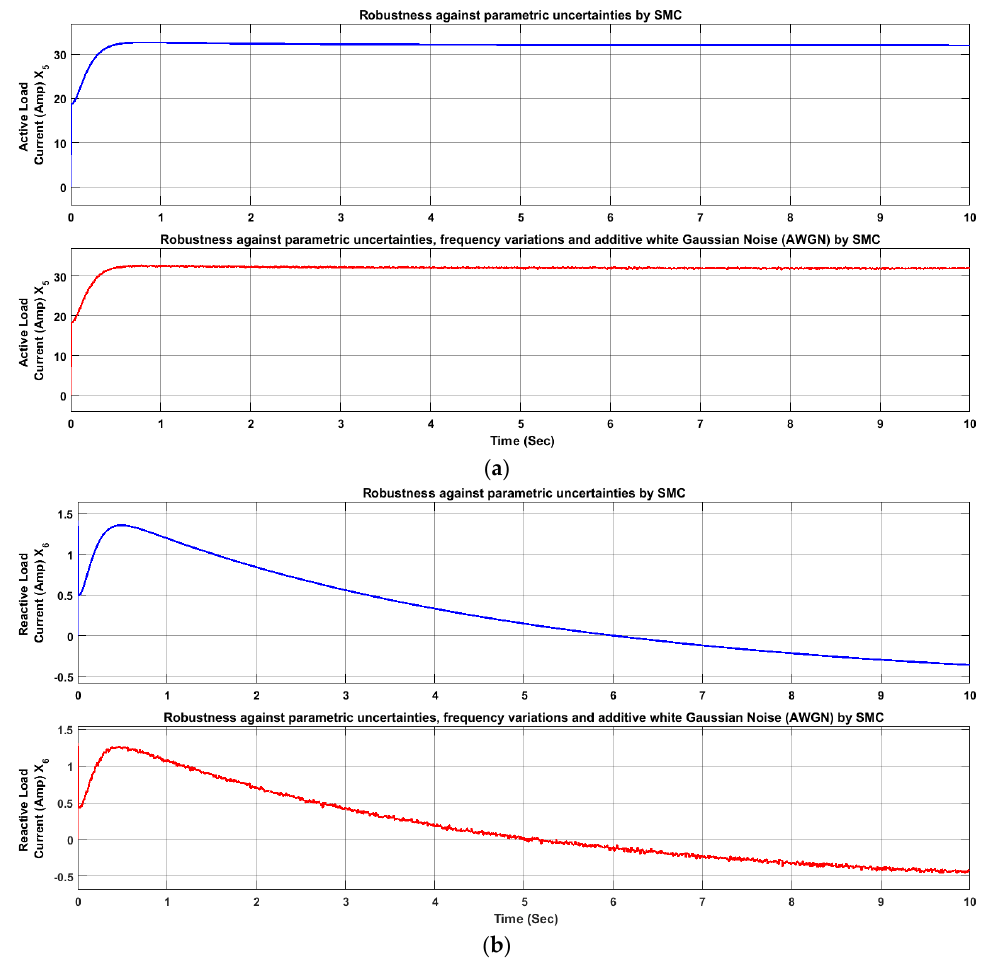
Figure 17. ( a ) d-axis current (CVL load) comparison; ( b ) q-axis current (CVL load) comparison, between robustness analysis against parametric variation and robustness analysis against parametric uncertainties, frequency variation and additive Gaussian noise using SMC control technique based on boundary condition.